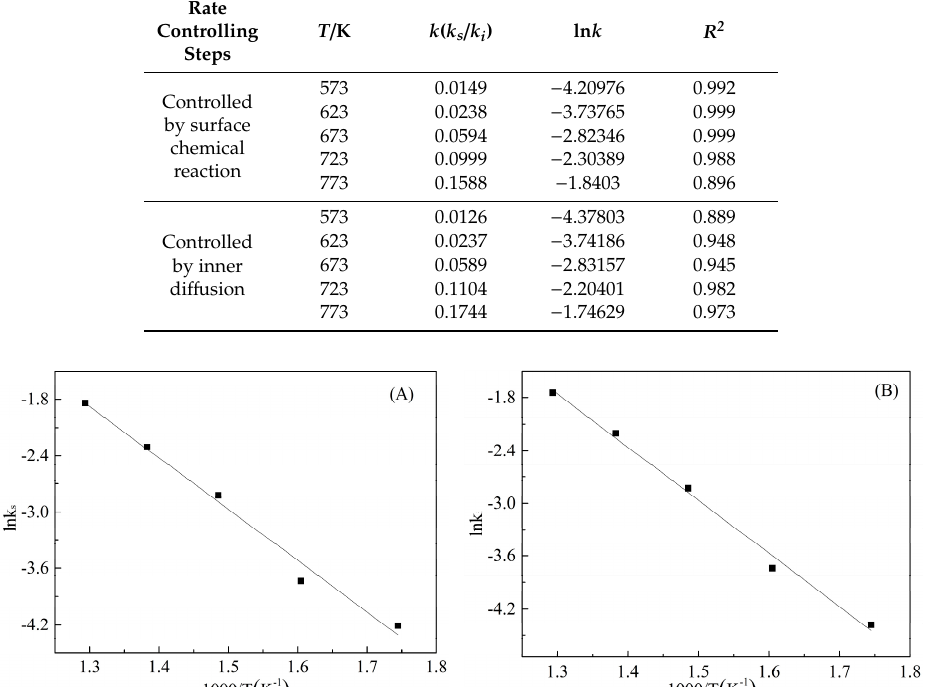
Table 4. Kinetic parameters of shrinking core model.